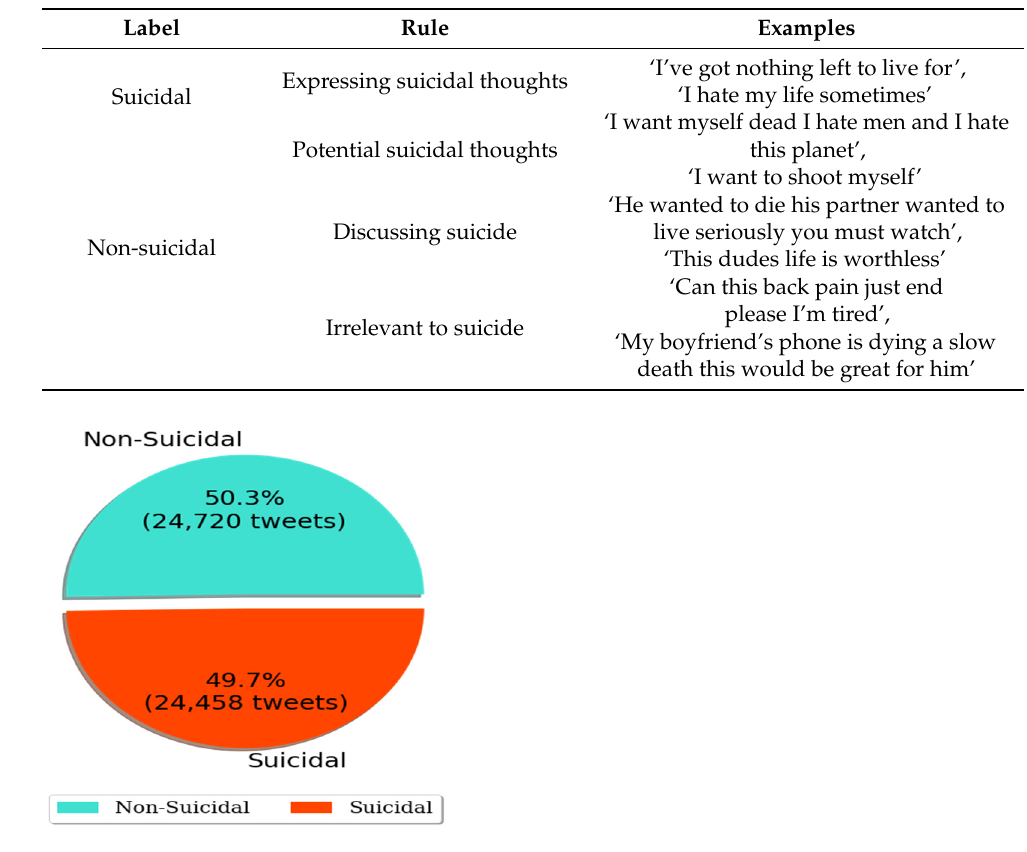
Table 1. Data Annotation Rules.